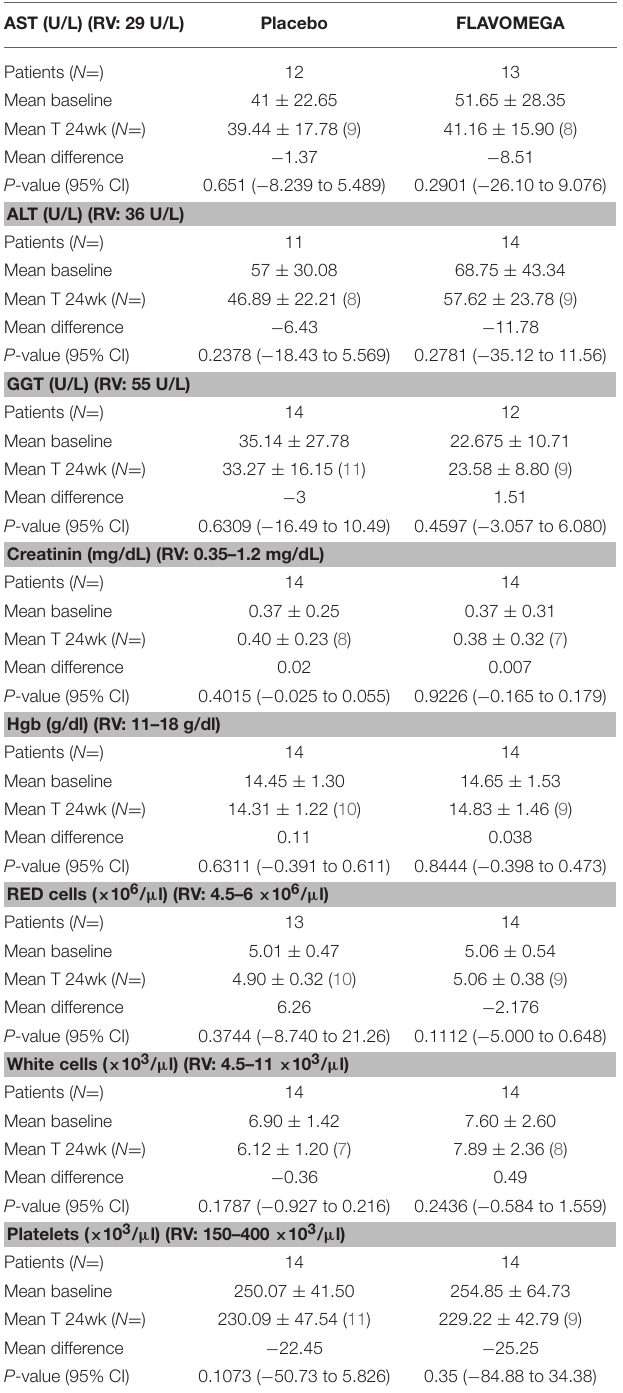
TABLE 7 | Linear regression of repeated measure (MMRM) analysis of secondary endpoints: safety blood test parameters. AST (U/L) (RV: 29 U/L)